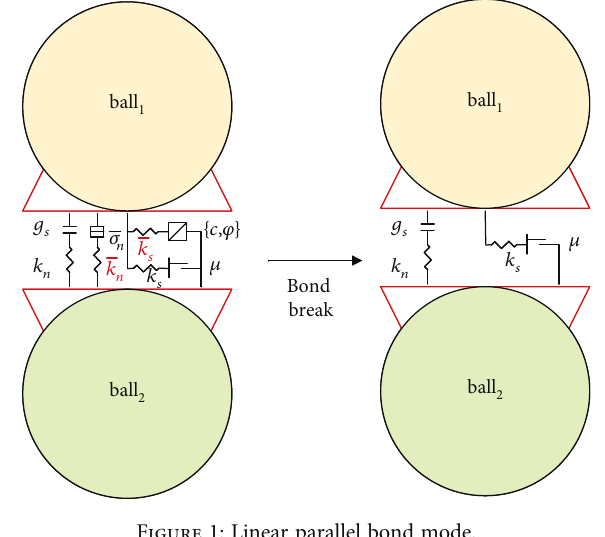
Figure 1: Linear parallel bond mode.